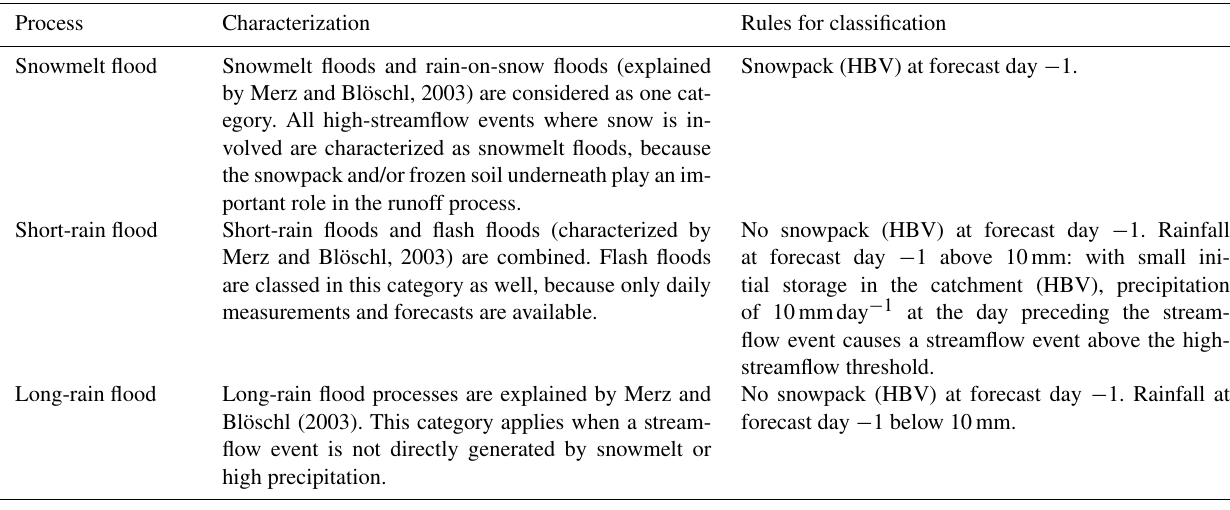
Table 3. Characterization of the low-streamflow-generating processes. Process